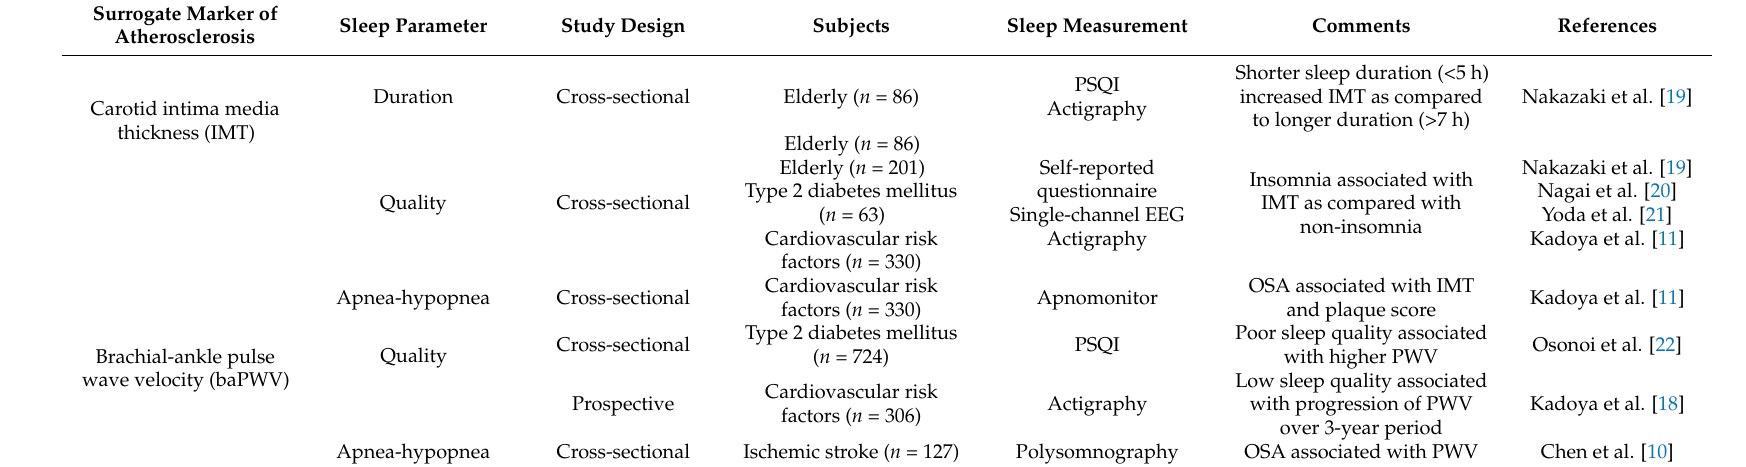
Table 1. Association of subjective or objective sleep duration and quality with carotid IMT and baPWV in patients with atherosclerotic risk